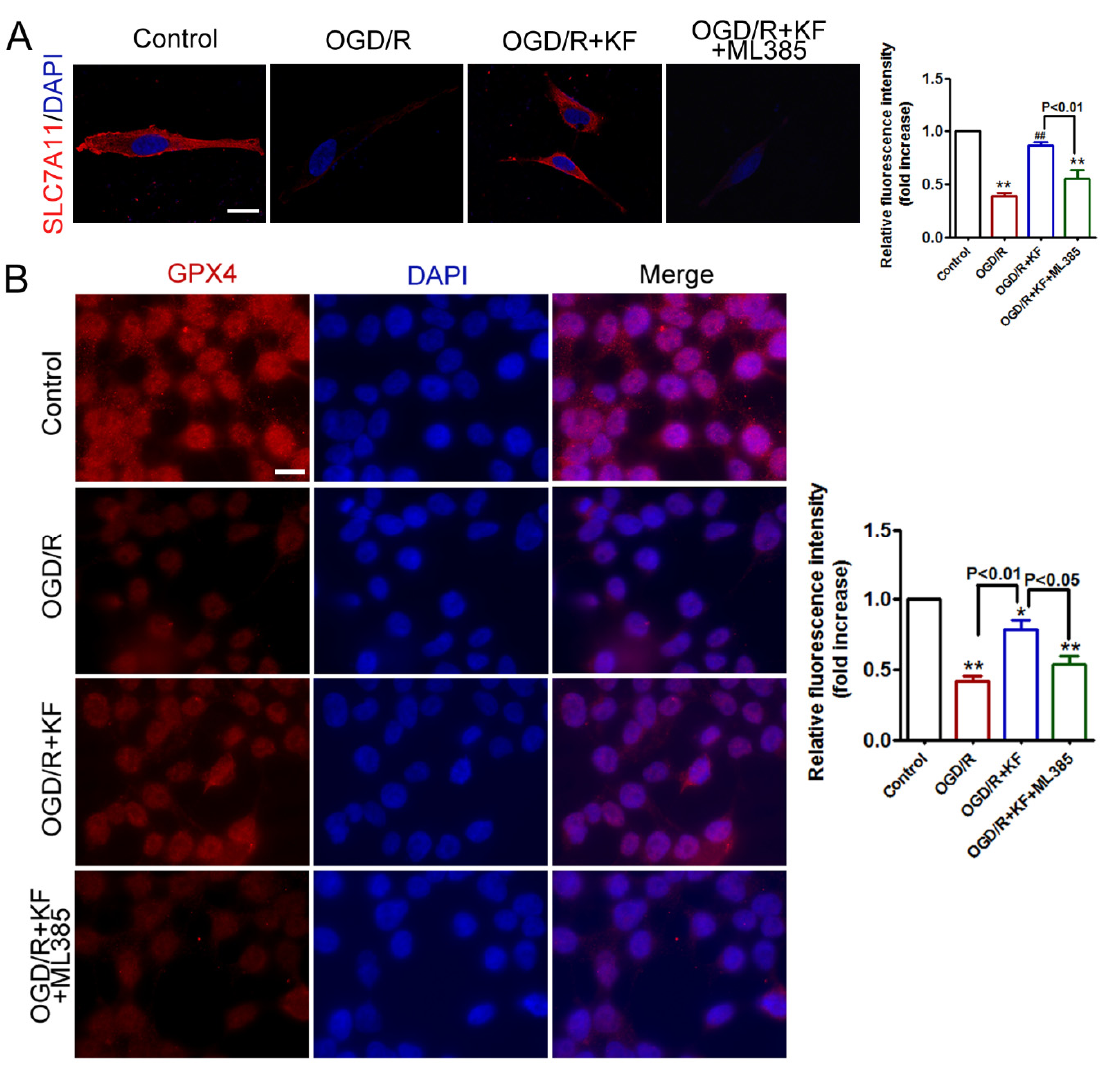
Figure 2. Effects of kaempferol on GPX4 and SLC7A11 expression in OGD/R-treated neurons. ( A ) Neurons were treated as indicated in (Figure 1A). Neurons were then immunostained using antibody specific for SLC7A11 (red). Nucleus is stained with DAPI (blue). Representative confocal images of the indicated neurons from three independent experiments. Scale bar, 15 µm. ( B ) Neurons were treated as indicated in (Figure 1A). Neurons were then immunostained using antibody specific for GPX4 (red). Nucleus is stained with DAPI (blue). Images were acquired using a fluorescence microscope. Representative immunostaining images of the indicated neurons from three independent experiments. Scale bar, 15 µm. * p < 0.05 versus control; ** p < 0.01 versus control; ## p < 0.01 versus OGD/R.